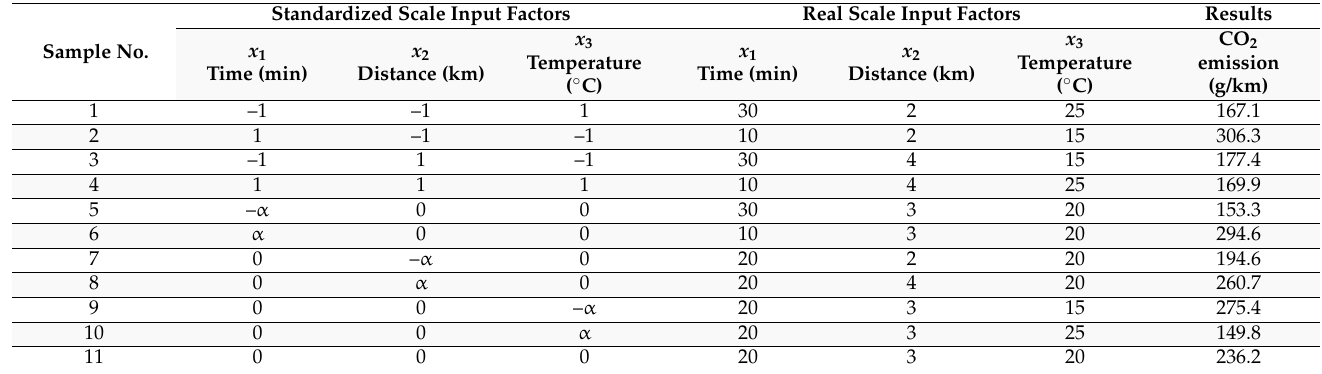
Table 2. Road test conditions and CO 2 emission values—vehicle with an ICE.